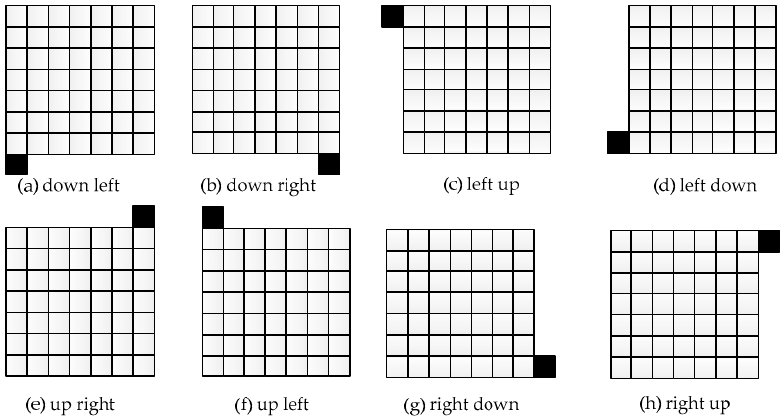
Figure 6. The eight different templates used in our method. The black squares stand for the missing pixels, and the white squares are the successfully received ones.